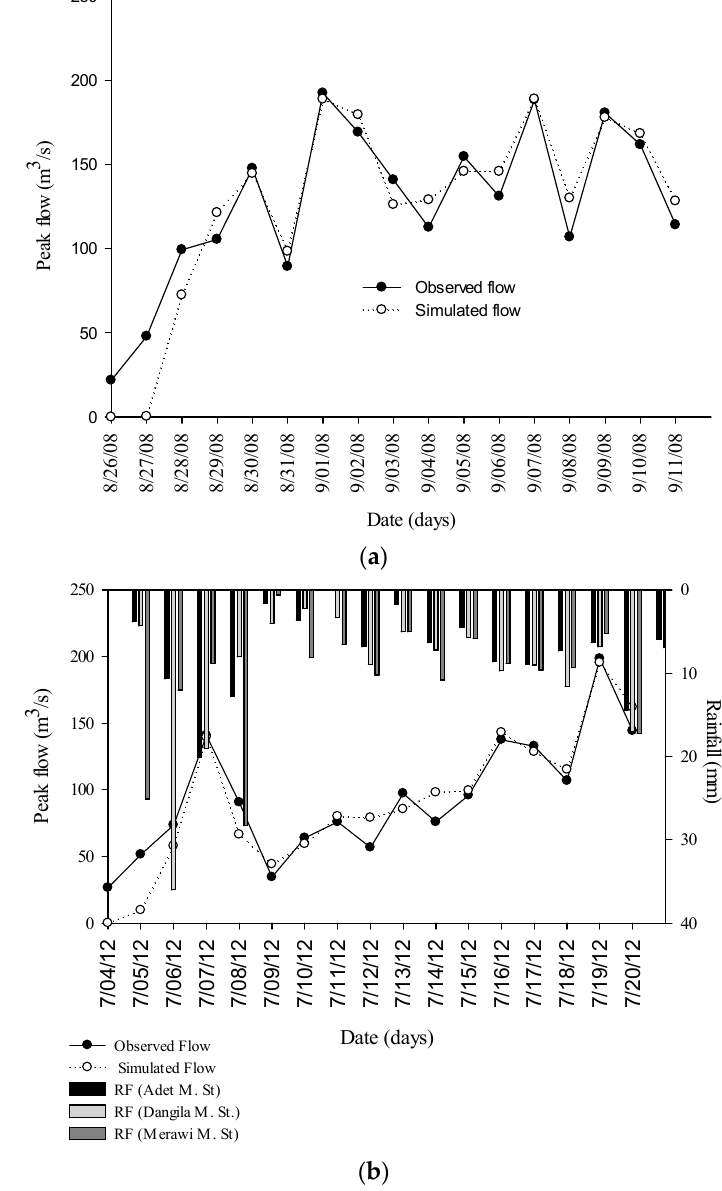
Figure 4. Comparison of simulated and observed hydrographs during validation ( a ) Model output for event 8 (26 August–11 September, 2008) and ( b ) Rainfall of contributing stations and simulated and observed hydrographs of Event 9 (04–20 July,